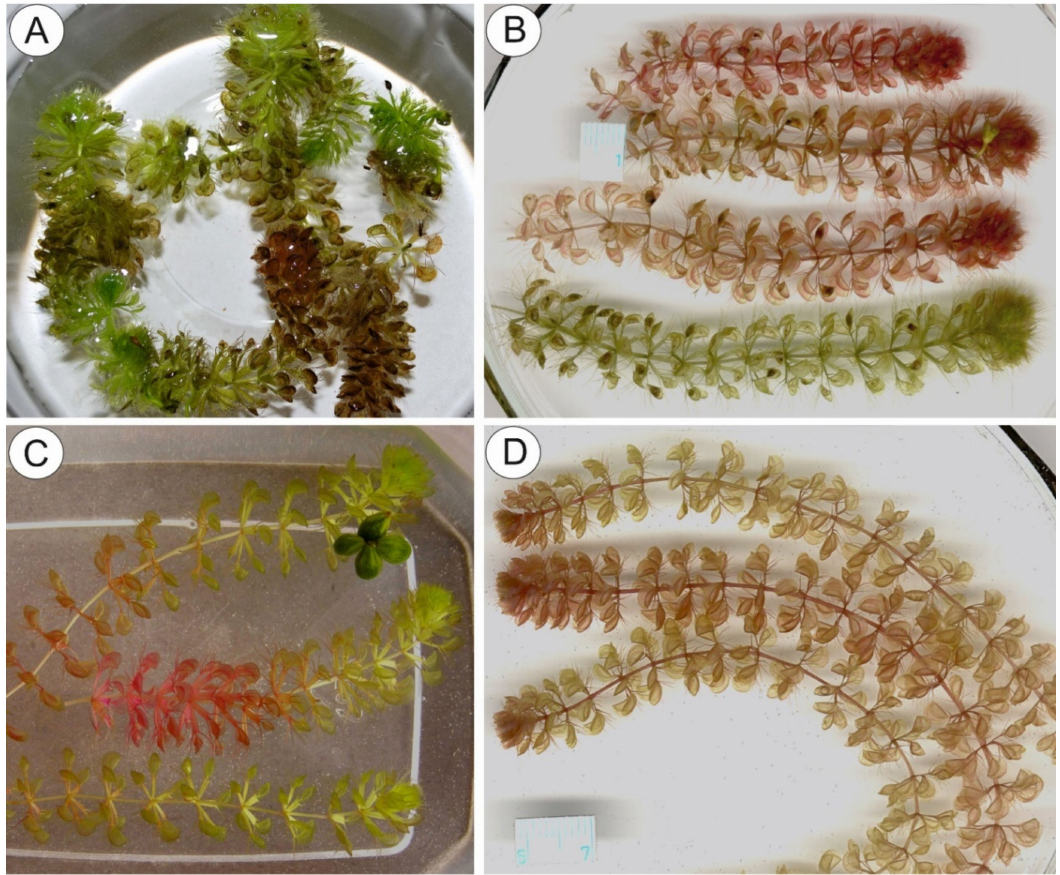
Figure 1. Diversity of Aldrovanda vesiculosa plants from different geographical origins. ( A ) Green plants from Lake Prespa, S Northern Macedonia. ( B ) Plants from Lake Bal á ta-t ó , Somody county, SW Hungary. ( C ) Plants from Katherine, NT, N Australia. ( D ) Plants from Shallow Okavango delta, Botswana,